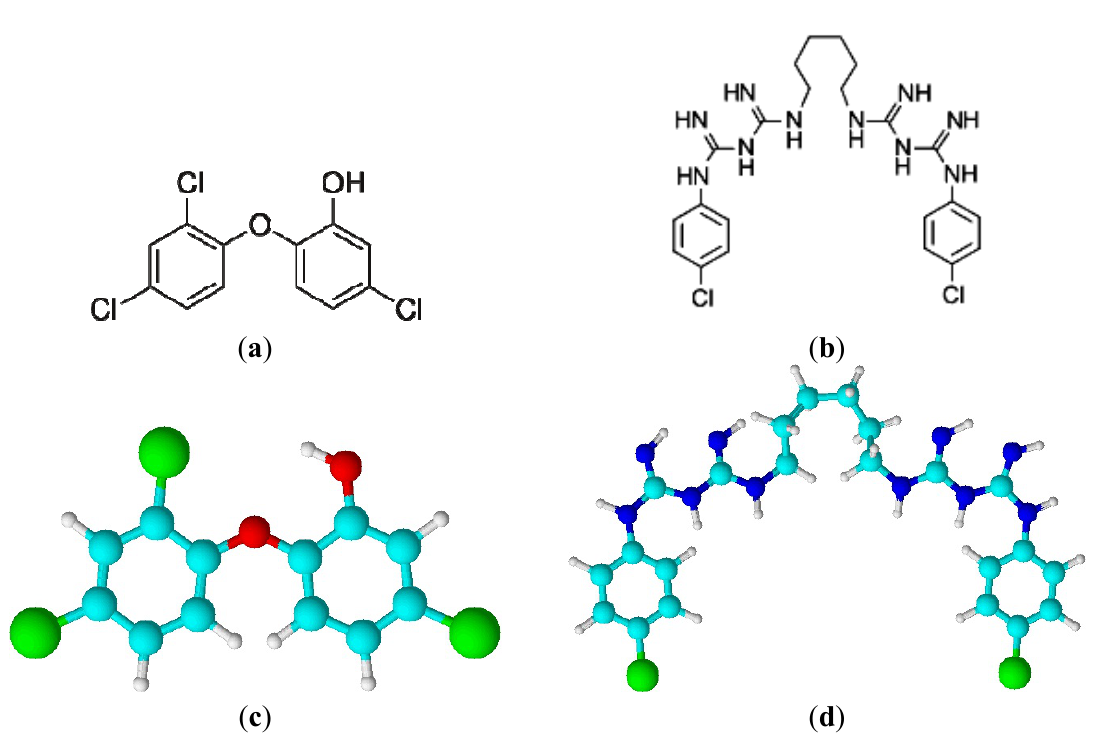
Figure 1. ( a ) triclosan; ( b ) chlorhexidine; ( c ) 3D structure of triclosan; ( d ) 3D structure of